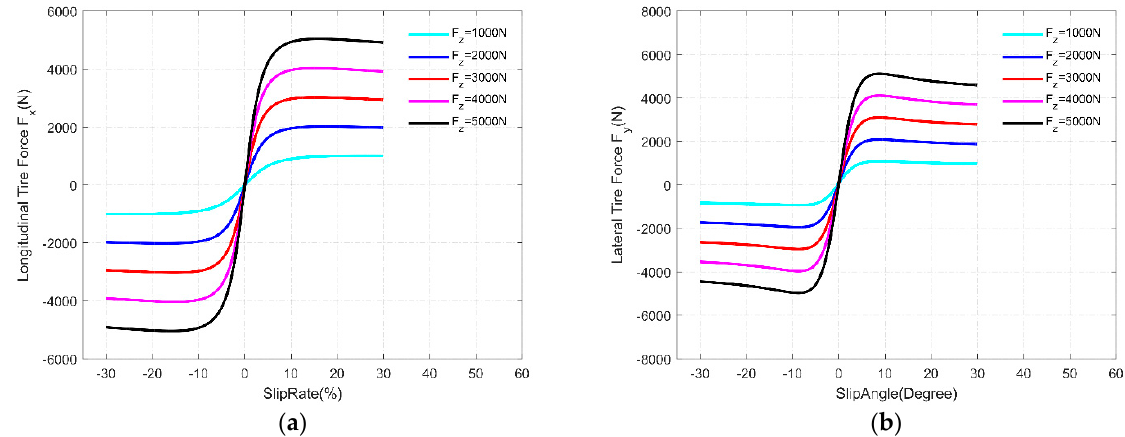
Figure 3. Longitudinal force and lateral force in pure slip circumstances. ( a ) Longitudinal force in pure slip circumstances, with slip rates from − 0.3 to 0.3; ( b ) Lateral force in pure slip circumstances, with sideslip angles from − 30 ° to 30 ° .